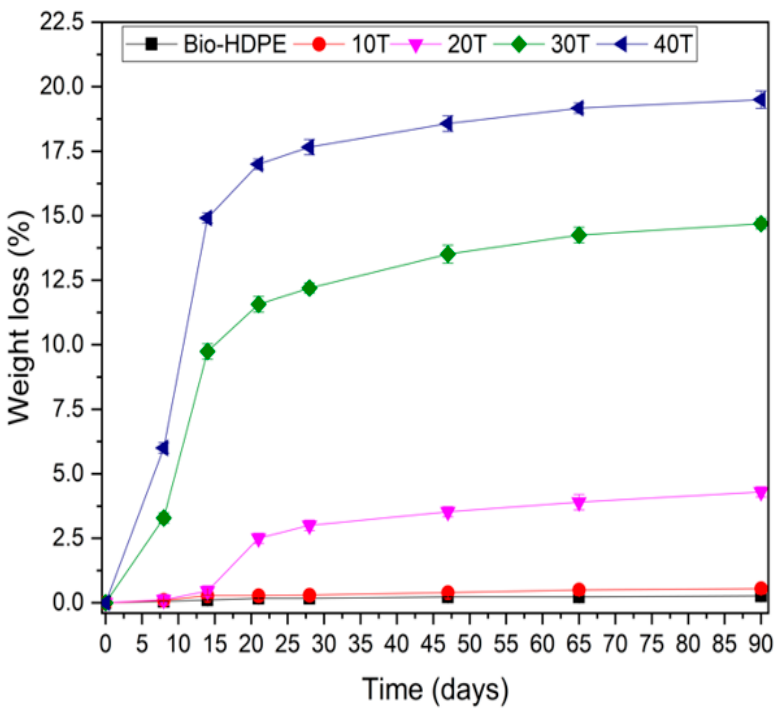
Figure 13. Weight loss of bio-based high-density polyethylene (Bio-HDPE) with different weight percentage of treated chia seed flour with APS.